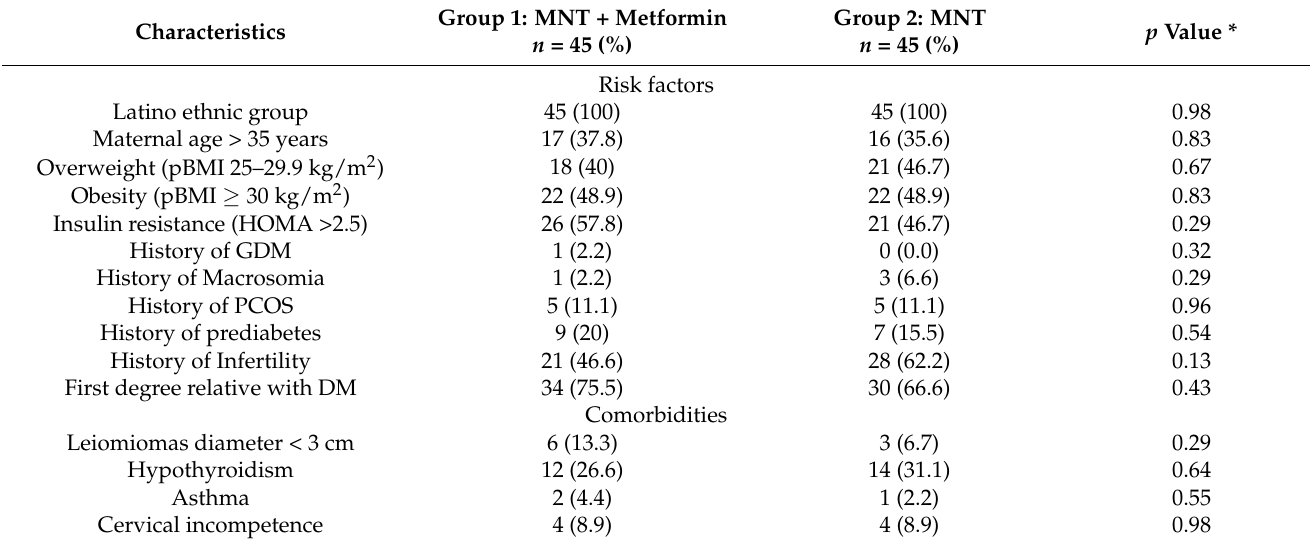
Table 4. Risk factors for gestational diabetes mellitus and comorbidities of participants at admission of the